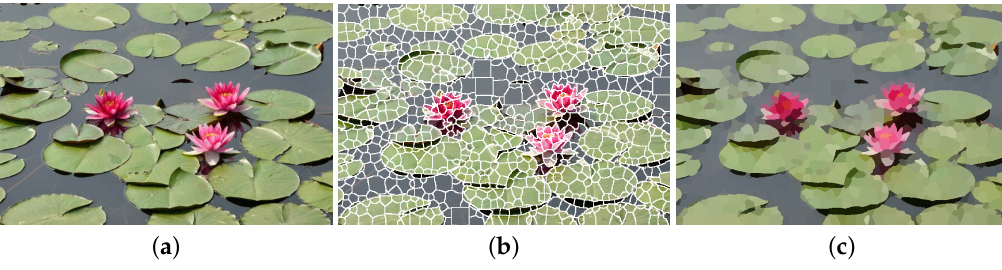
Figure 2. The process of superpixel pre-segmentation. ( a ) The original image. ( b ) We partition the original image into multiple homogeneous. ( c ) The superpixel level map. Calculating the average of the color features for each superpixel region and use that value to replace the pixel values for all points in the region. In this process, not only can maximize the retention of the effective information but can drop some unnecessary noise, the complexity of the calculation will be greatly reduced.